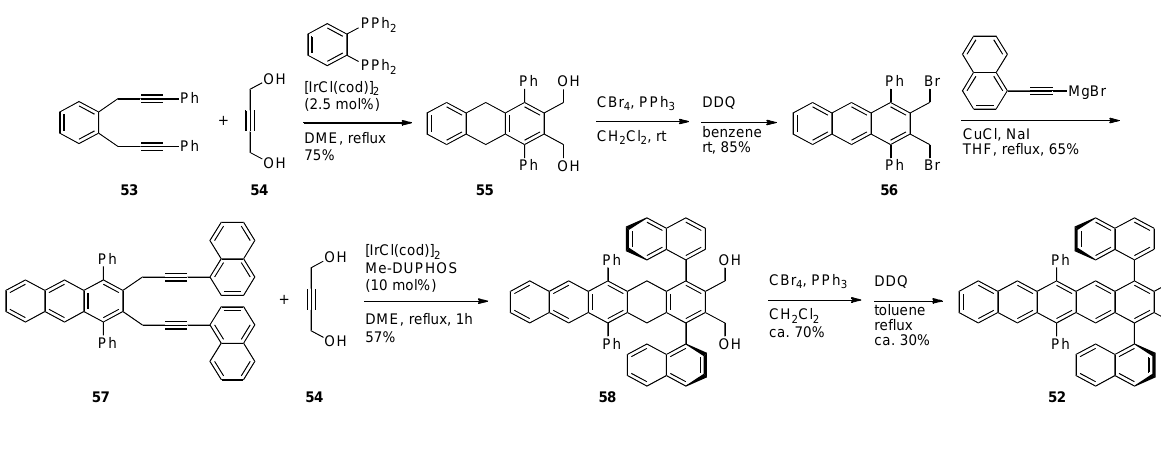
Scheme 5. Synthesis of axially chiral pentacene 52